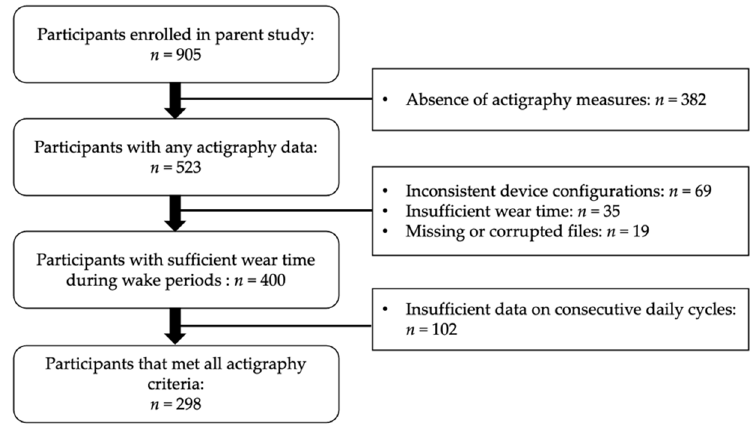
Figure 1. Participant flow diagram.